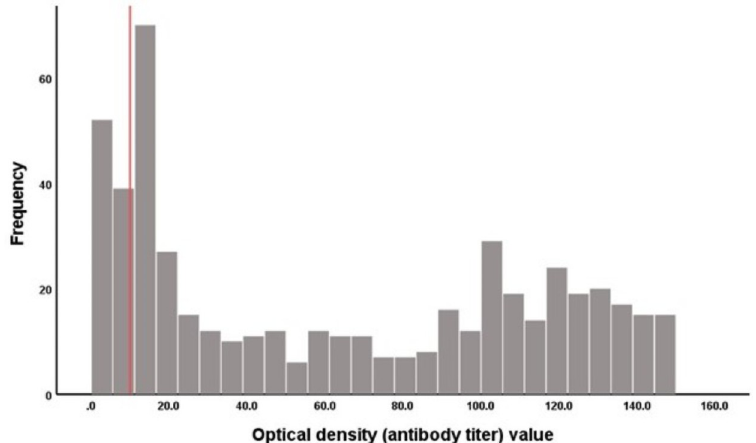
Fig 1. Distribution of optical density (antibody titer) values among 510 specimens that were seropositive in the Roche Elecsys Anti-SARS-CoV-2 test. The red line represents the threshold value of ‘10’ that stratifies the distribution of Elecsys optical density values into lower and higher antibody titer